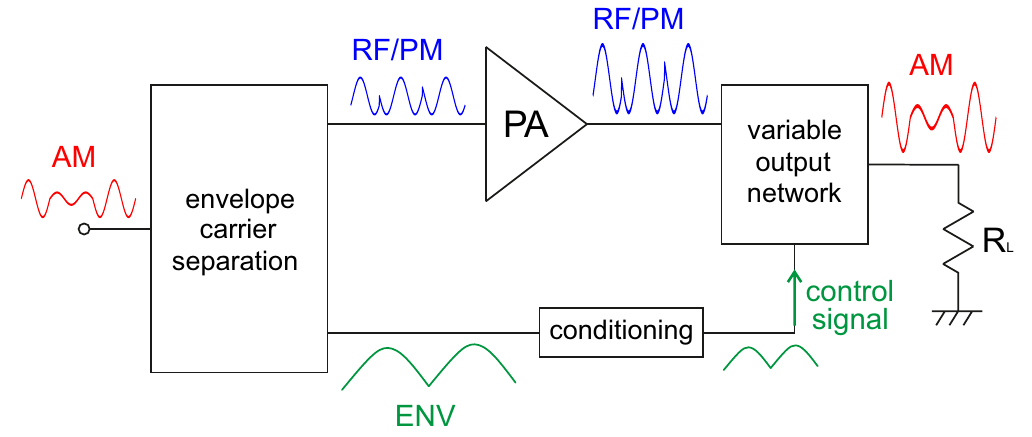
Figure 17. Dynamic load modulation. RF: Radio Frequency; ENV: